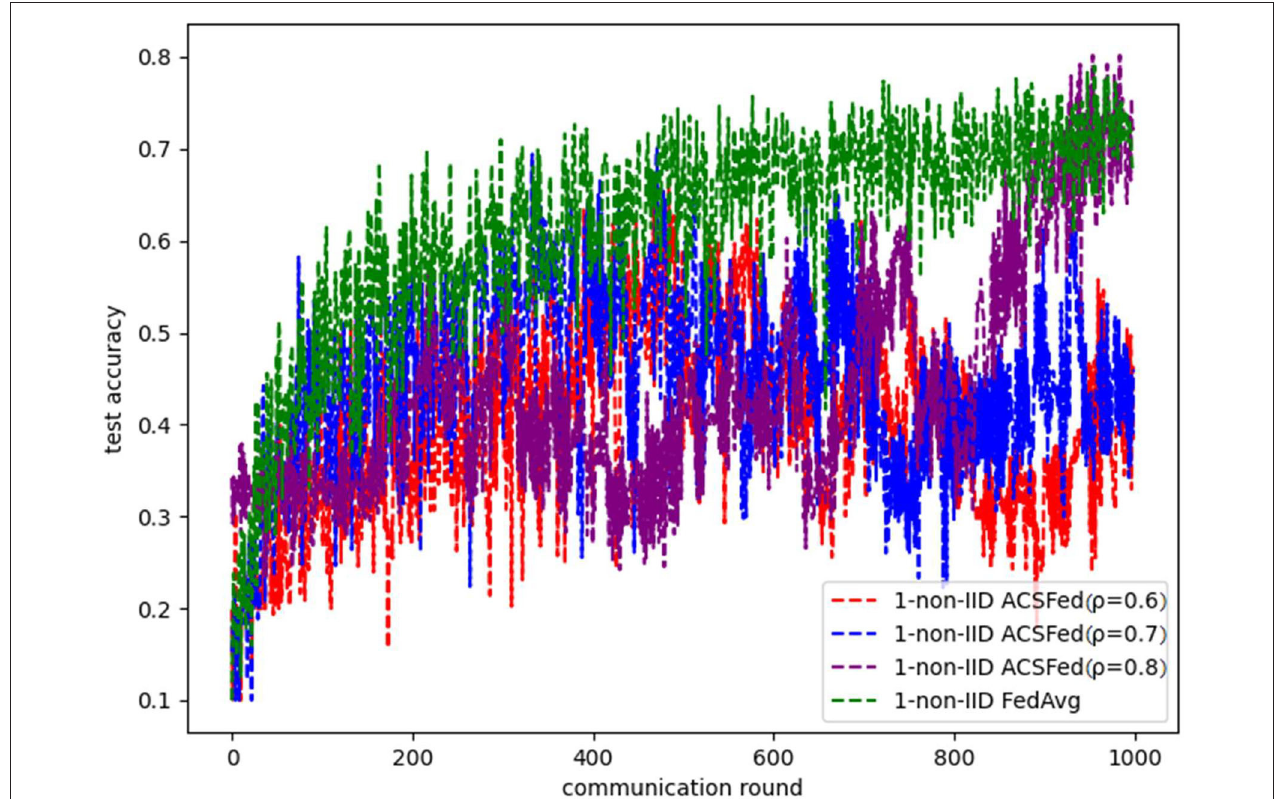
FIGURE 8 | Test accuracy on fashion MNIST in the 1-class non-IID scenario.